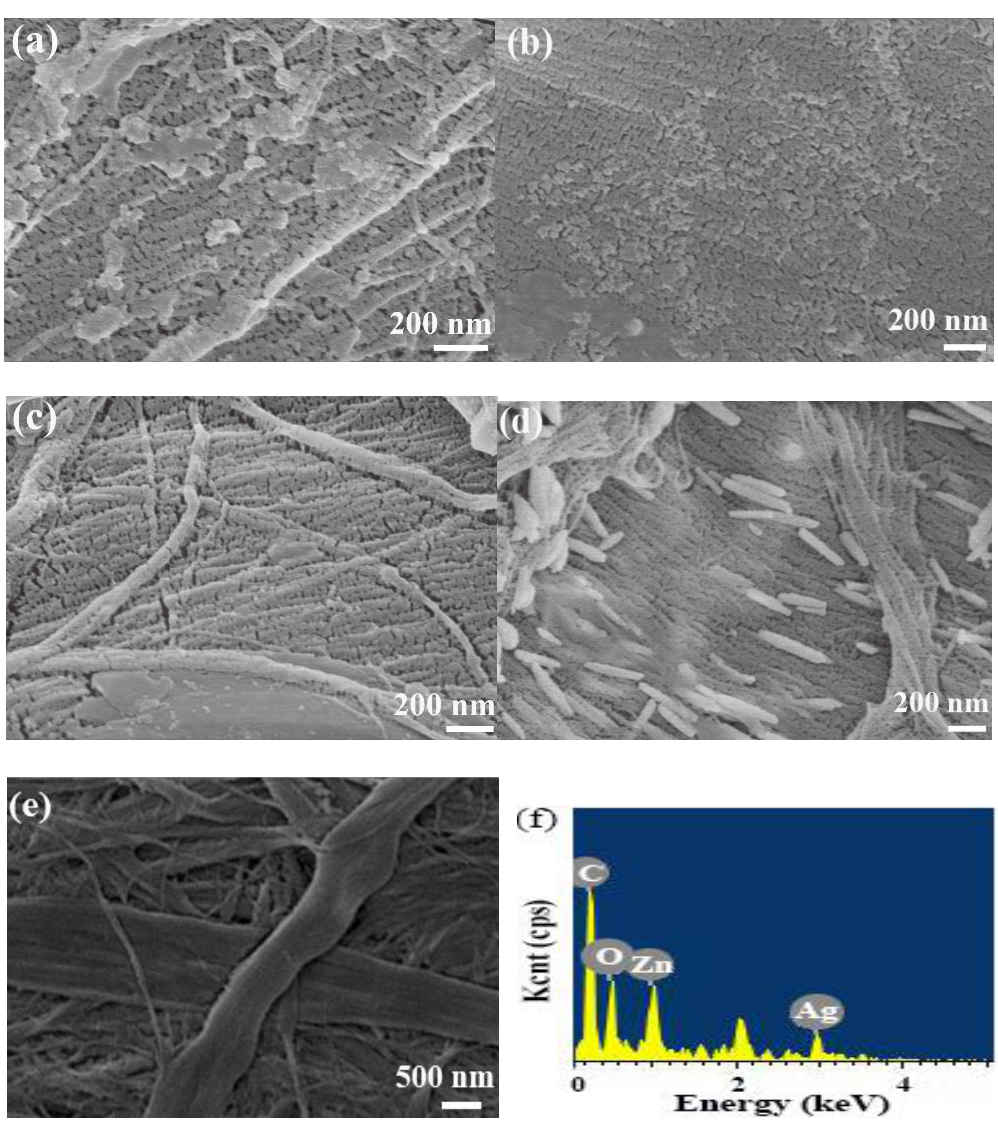
Figure 2: SEM images of ZAC composite samples (a) ZAC-8, (b) ZAC- 9, (c) ZAC-10, (d) ZAC-12, (e) pure cellulose and f) EDS of